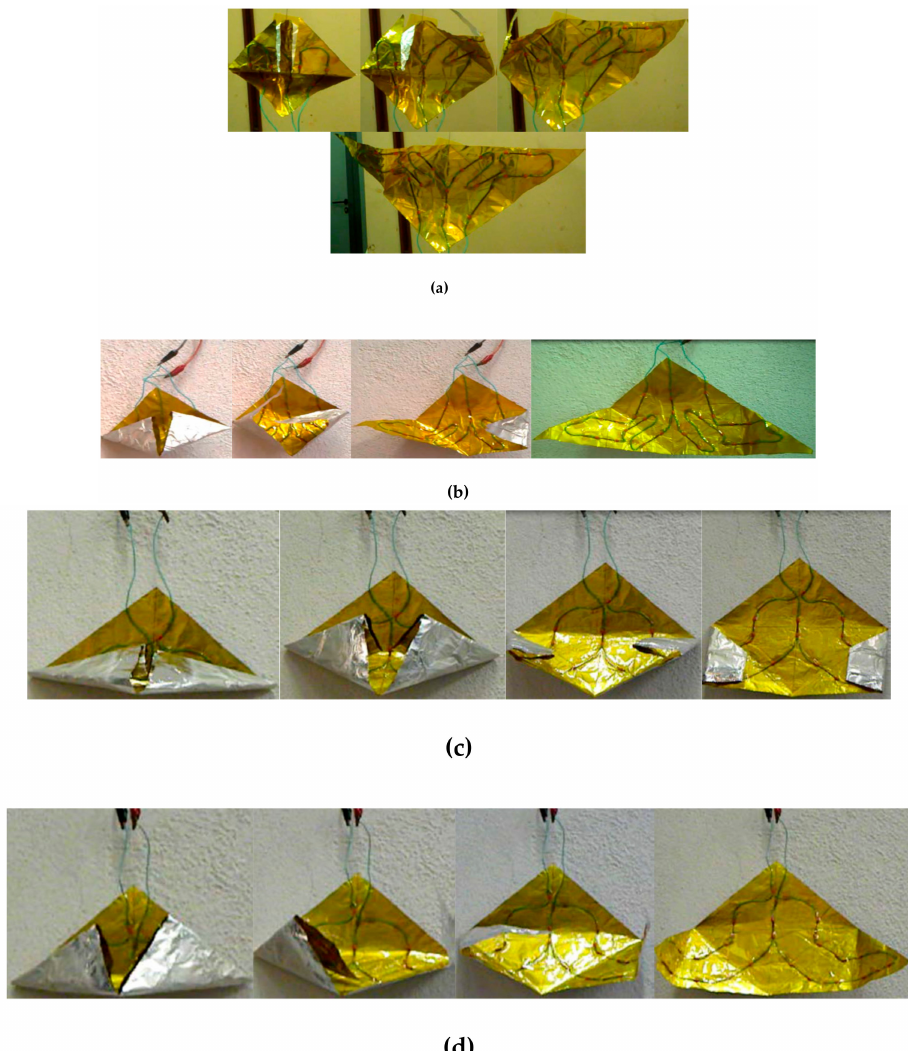
Figure 8. Sail prototypes: deployment sequence of configuration 1 ( a ), 2 ( b ), 5 ( c ), and 6 ( d